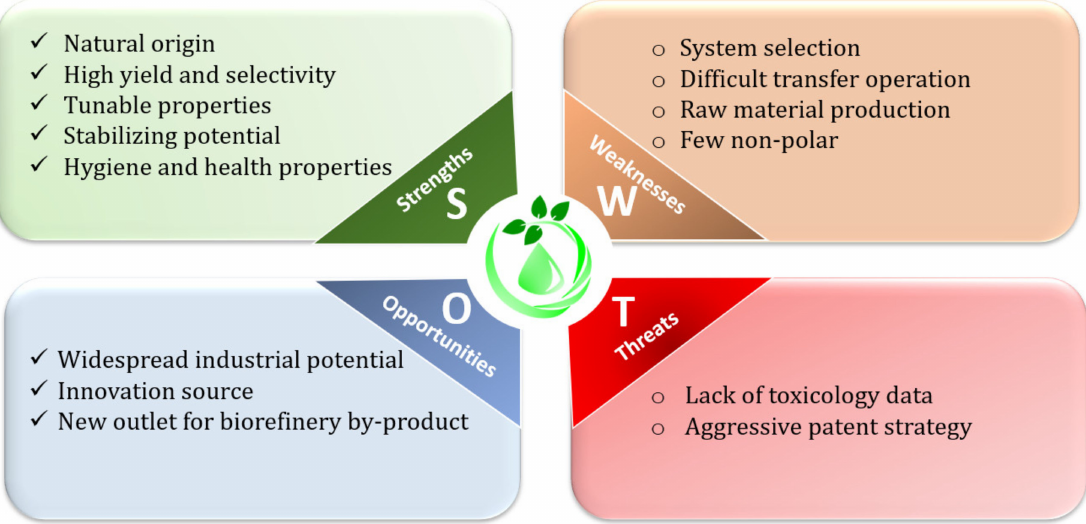
Figure 4. SWOT analysis of NaDES for biomass